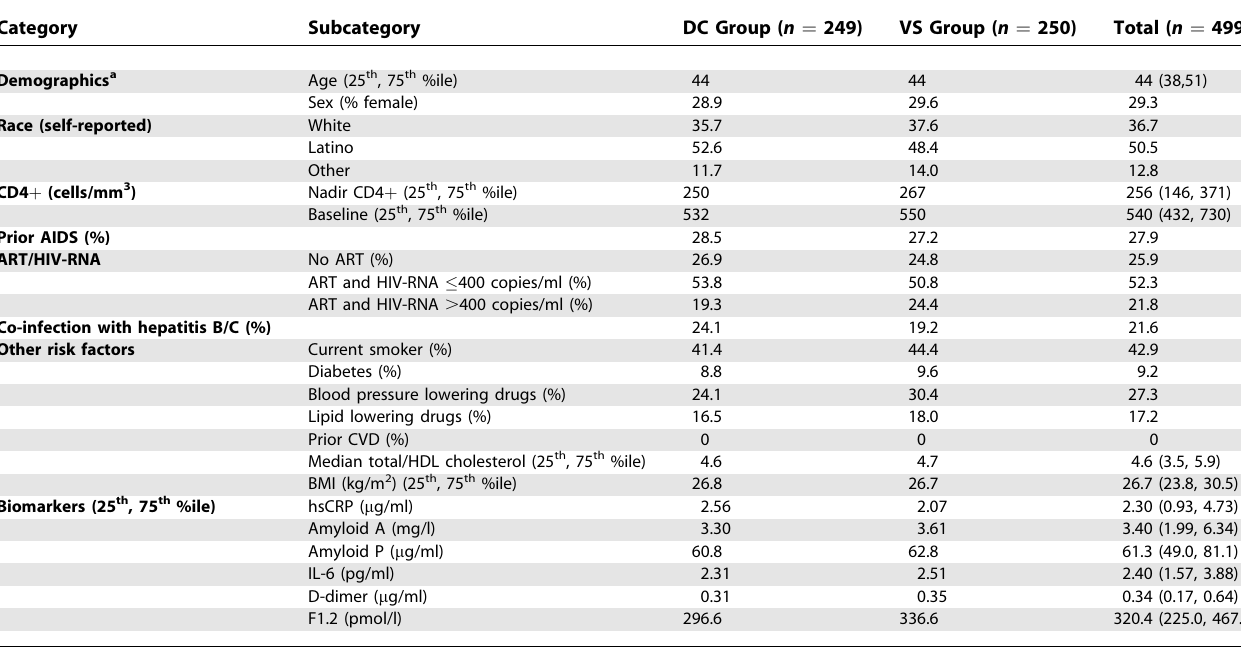
Table 6. Characteristics of Random Sample of DC and VS Participants at Study Entry